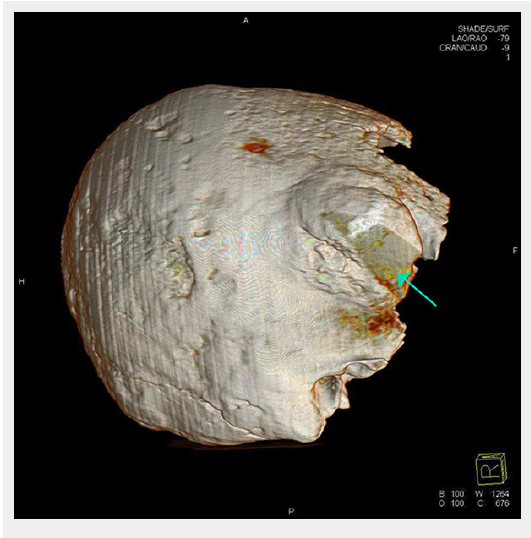
Computed tomography three-dimensional reconstruction of the skull. Wedge-shaped area in the centre of the lesion filled with material of lower X-ray density than the adjacent bone (green arrow).